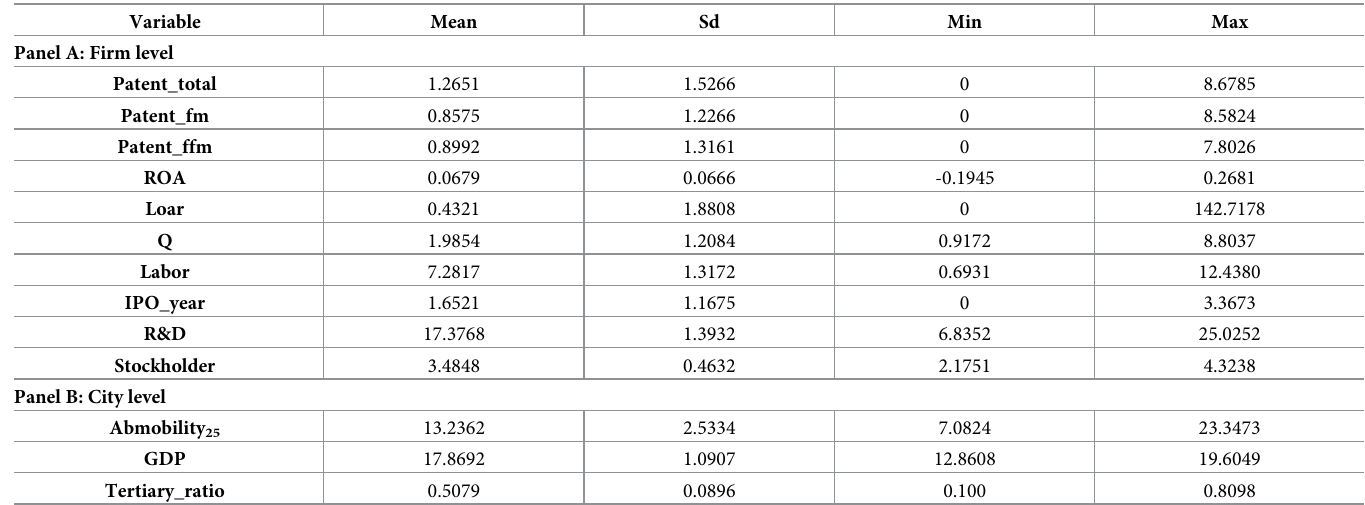
Table 1. Summary